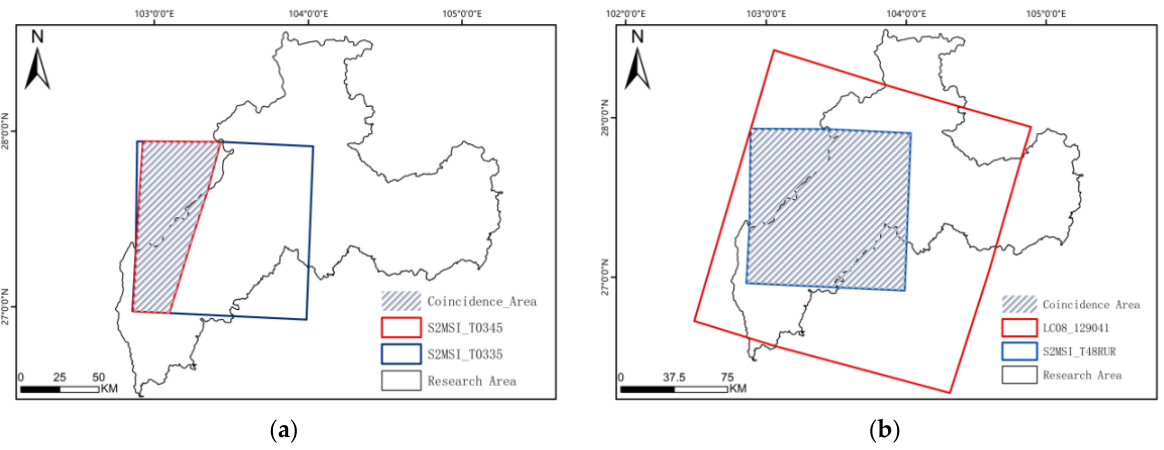
Figure 5. The overlapping area of the benchmark image and the image to be corrected in di ff erent situations. ( a ) Images from the same sensor (Sentinel-2) on di ff erent days; ( b ) Images from di ff erent sensors (Sentinel-2 MSI and Landsat-8 OLI) on di ff erent days.